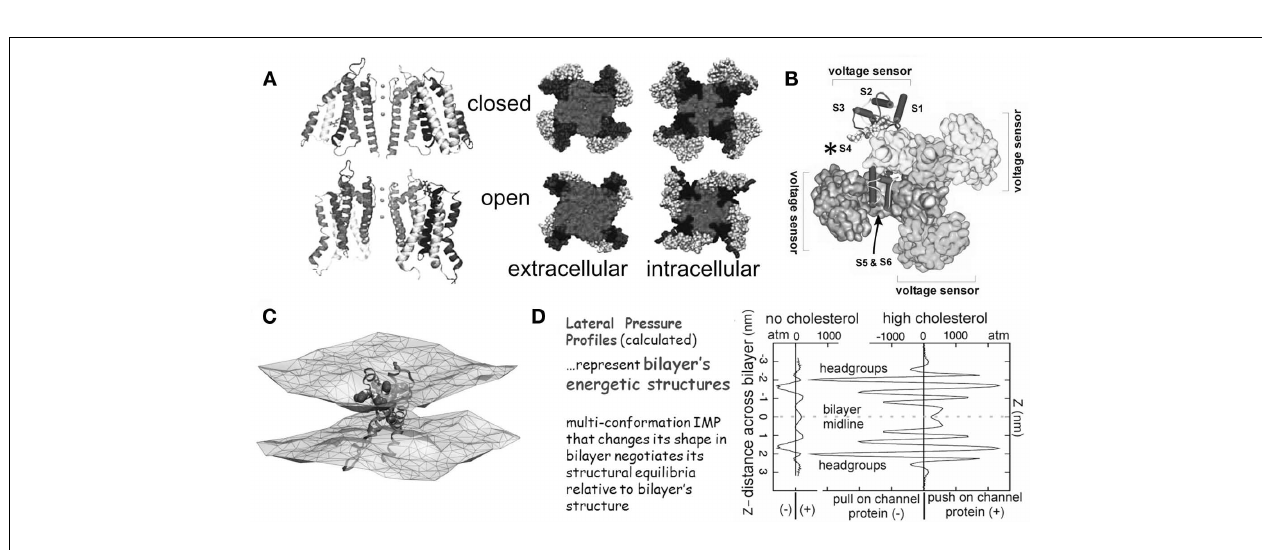
(see Long et al., 2007). (C) A single activated-state voltage sensor domain modeled in lipid bilayer (the two water/lipid interfaces are depicted) showing that in its activated-state, the sensor locally deforms/thins the bilayer (modified from Krepkiy et al., 2009). (D) Bilayers, too have different structures (and hence energetics) that are dramatic and lipid-dependent, as seen from these lateral pressure profiles calculated for two simple bilayers, one without, one with cholesterol. Cholesterol thickens a bilayer (see Z axis) and increases its packing order. For any shape-changing integral membrane protein (IMP), the lateral pressure profile is an important component of the energetic landscape (for further explanation see Morris and Juranka, 2007b; Finol-Urdaneta et al., 2010; Morris,